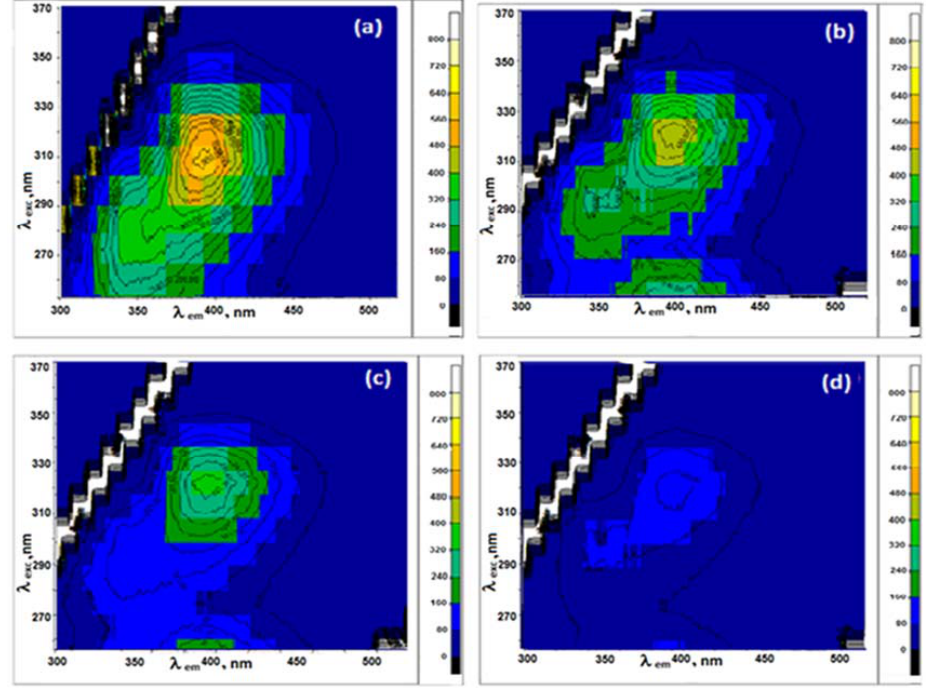
Figure 3 . 3D fluorescence contour maps of pyridoxine in ( a ) 20 mM SDS and G (0.5, 1.0, and 2.0 wt